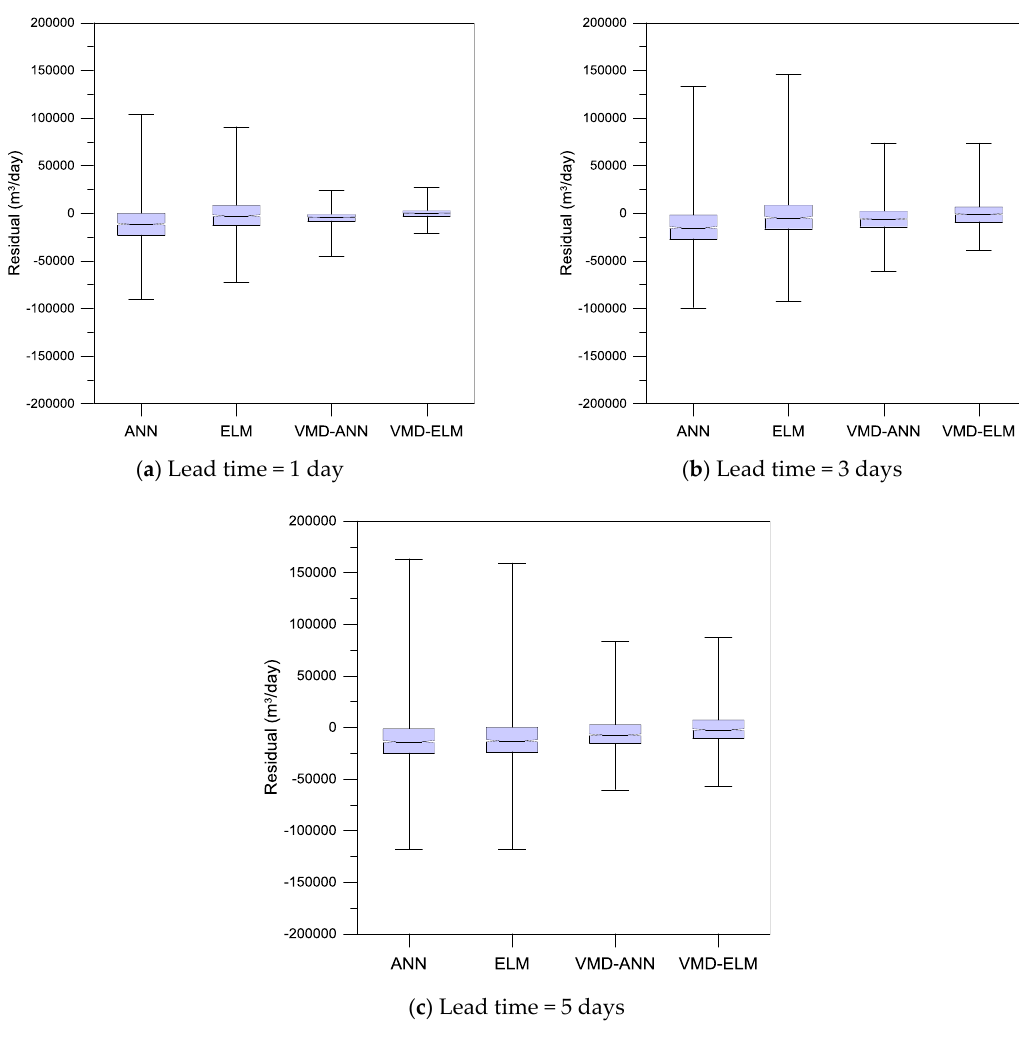
Figure 10. Residual boxplots for single and VMD-based forecasting models